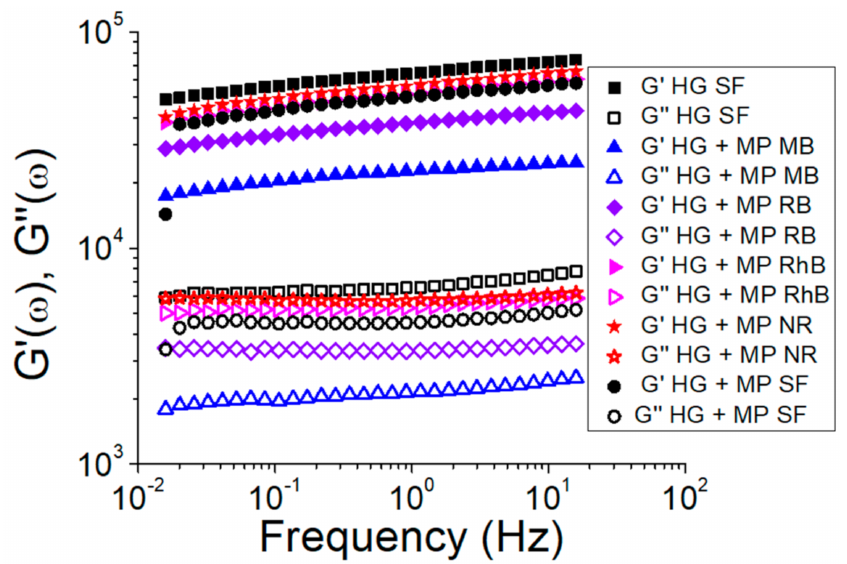
Figure 6. Storage (G (cid:48) ) and loss moduli (G”) as a function of the frequency of SF hydrogels with and without microparticles loaded with dyes. Closed points refer to the storage modulus (G (cid:48) ) and open points refer to the loss modulus